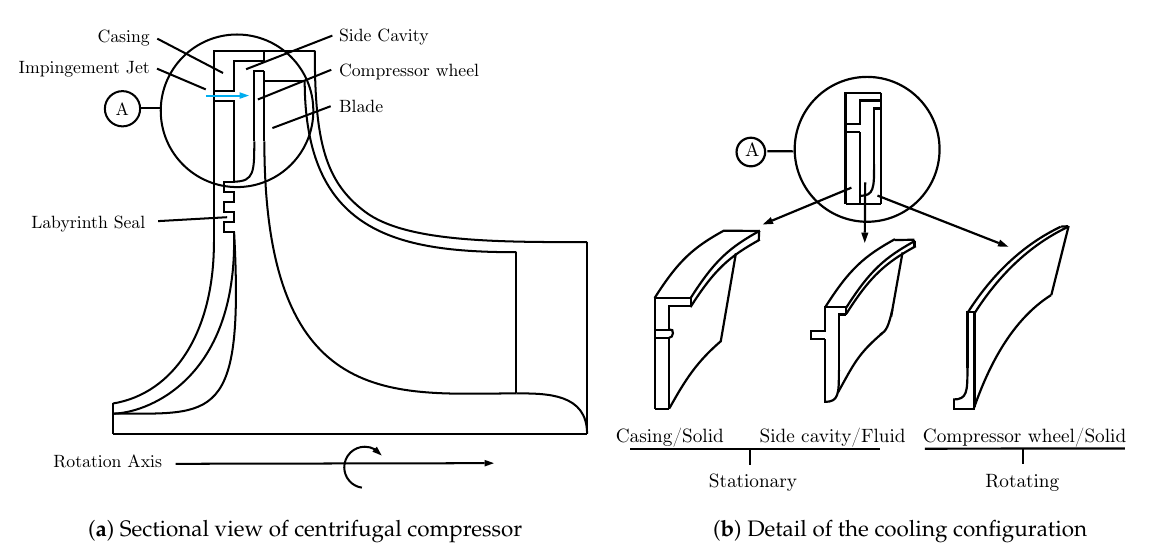
( b ) Detail of the cooling configuration Figure 1. Typical impingement jet cooling configuration Figure 1. Typical impingement jet cooling configuration Figure 1. Typical impingement jet cooling configuration.